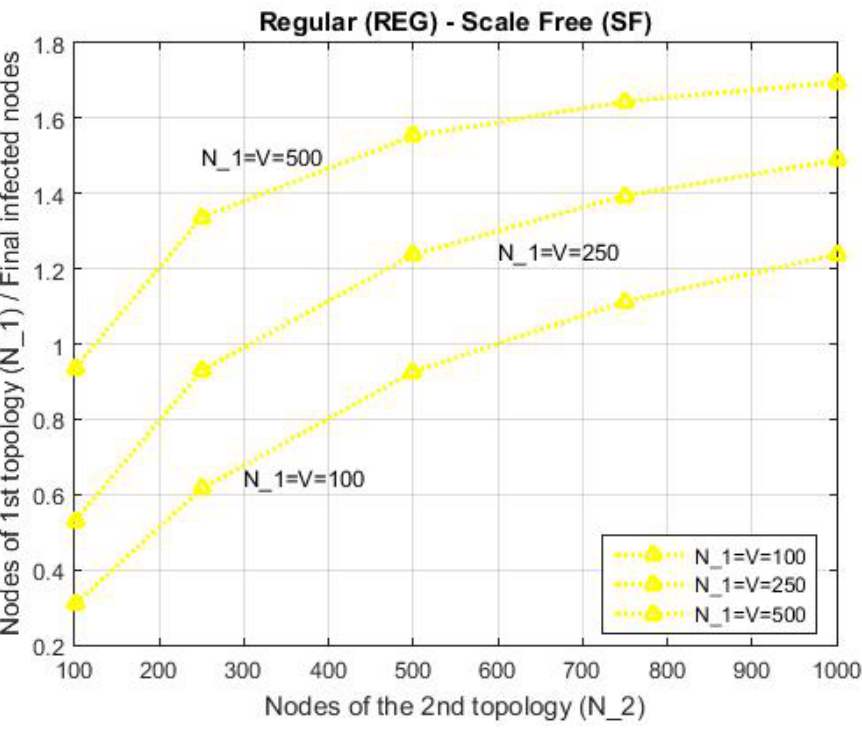
Figure 7. Regular and Scale-Free, while N_1 = 100, N_1 = 250 and N_1 =